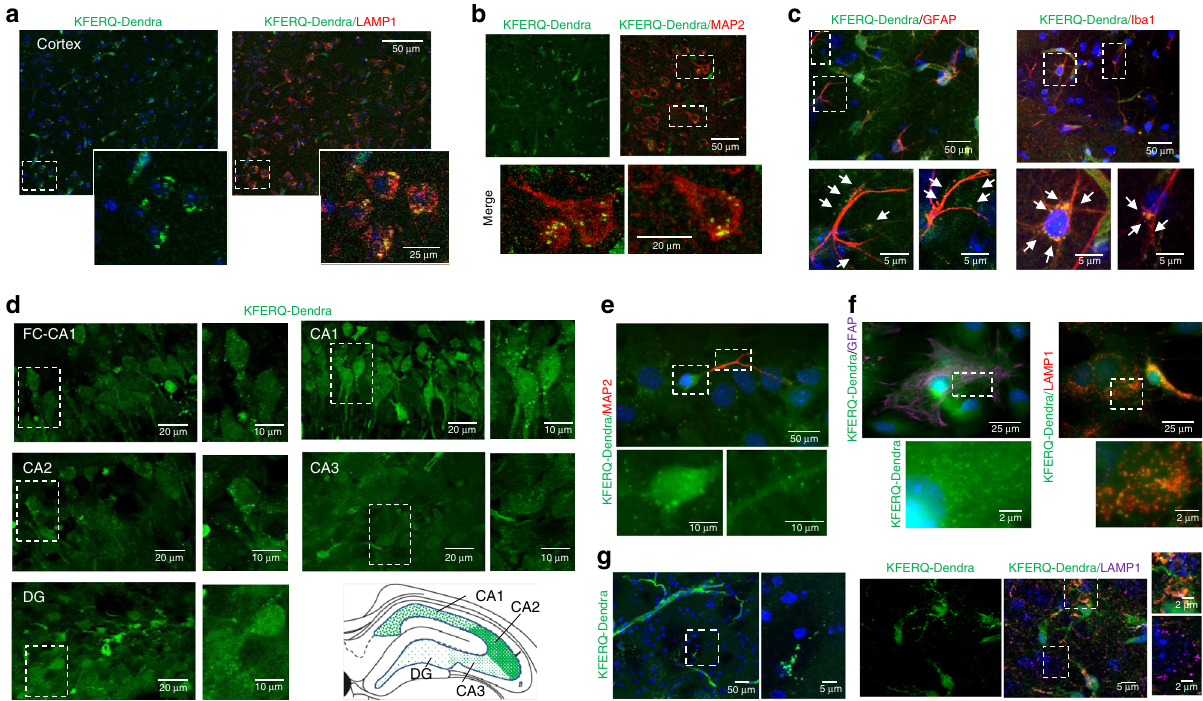
Fig. 3 CMA activity in brain. a Green fl uorescence (for KFERQ-Dendra) and immuno fl uorescence (for LAMP1) of cerebral cortex from KFERQ-Dendra mice. Insets: boxed area at higher magni fi cation. Nuclei are highlighted in blue. b , c Green KFERQ-Dendra fl uorescence in the same regions immunostained with MAP2 (to label neurons) ( b ), GFAP (to label astrocytes) or IBA1 (to label microglia). Arrows: green fl uorescent puncta. Boxed areas are shown at higher magni fi cation at the bottom ( c ). d Green KFERQ-Dendra fl uorescence in the indicated regions of the hippocampus of KFERQ-Dendra mice. Boxed areas are shown at higher magni fi cation on the right. The cartoon depicts the areas analyzed and abundance of the fl uorescent puncta in each region. e Direct KFERQ-Dendra fl uorescence in primary neuronal cultures prepared from KFERQ-Dendra mice brains. Insets show the boxed regions of soma and neurites at higher magni fi cation for the green channel only to better appreciate presence of fl uorescent puncta. f Green fl uorescence (for KFERQ-Dendra) and immuno fl uorescence (for GFAP or LAMP1) in primary astrocyte cultures prepared from KFERQ-Dendra mice brains. Boxed areas are shown at higher magni fi cation at the bottom. g Green fl uorescence (for KFERQ-Dendra) and immuno fl uorescence (for LAMP1) in brain sections from KFERQ-Dendra mice 4 days after culture. Merged images are shown on the right, where nuclei are highlighted with DAPI. Boxed areas are shown at higher magni fi cation on the right. Experiments were repeated 3 times (for a , b , d ) and 5 times (for c , e , f , g ) with similar